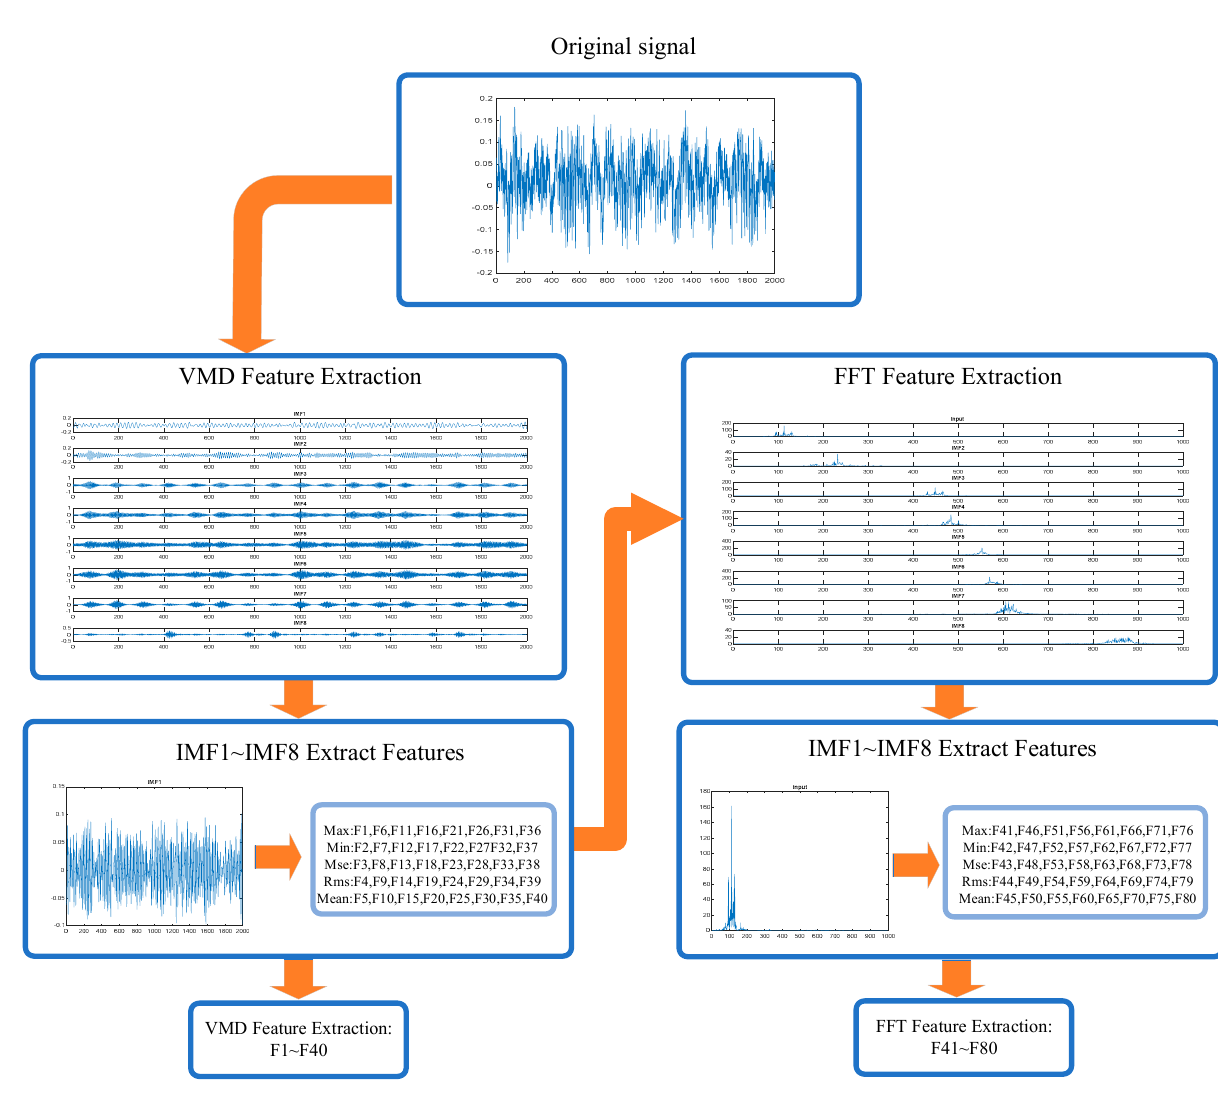
Figure 1. Feature extraction method fl owchart.